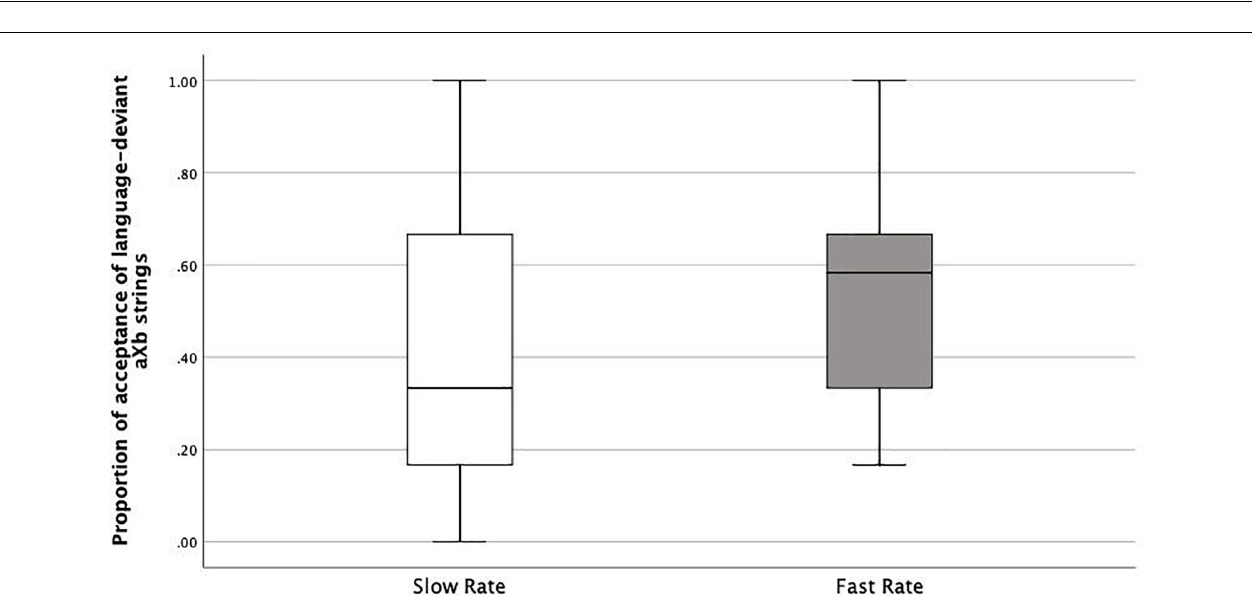
FIGURE 6 | Boxplots of proportions of acceptance of language-specific aXb strings in Slow Rate Condition as compared to Fast Rate Condition.